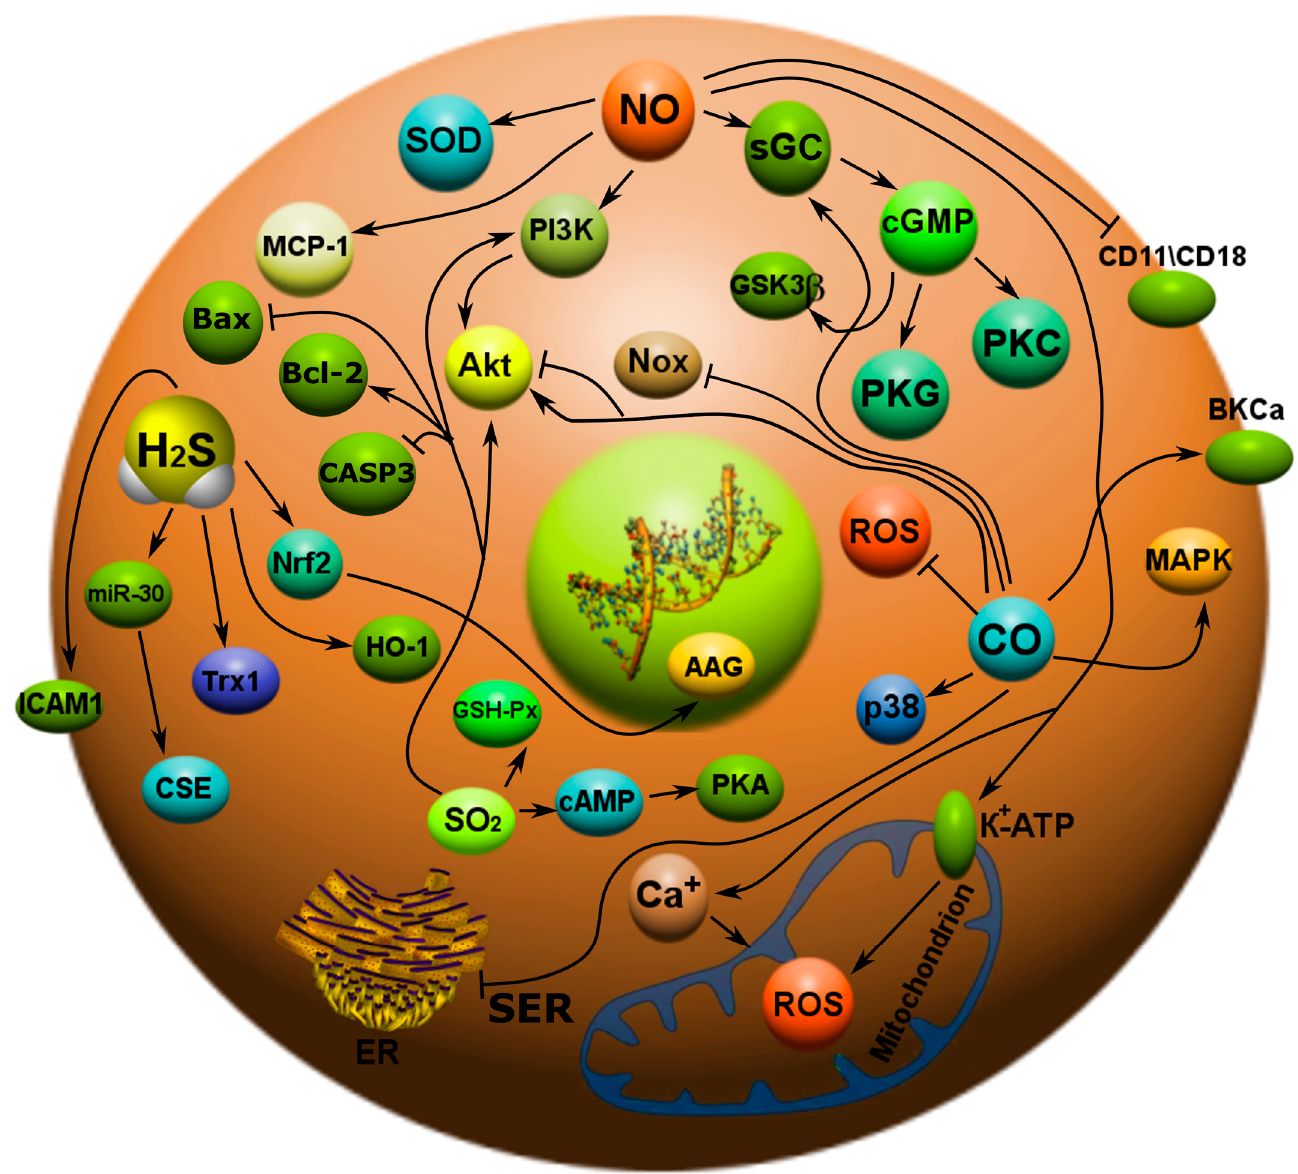
Figure 6. Possible gasotransmitter-dependent signaling mechanisms regulating apoptosis in cardiovascular diseases. NO, nitric oxide; CO, carbon monoxide; H 2 S, hydrogen sulfide; SO 2 , sulfur dioxide; SOD, superoxide dismutase; sGC, soluble guanylyl cyclase; cGMP, cyclic guanosine monophosphate; PKA, protein kinase G; PKC, protein kinase C; PKG, protein kinase G; PI3K, phosphoinositide 3-kinases; Akt, protein kinase B; Bax, bcl-2-like protein 4; Bcl-2, B-cell lymphoma 2; CASP3, cysteine-aspartic acid protease 3; MCP-1, monocyte chemoattractant protein 1; miR-30, microRNA-30; Trx1, thioredoxin 1; CSE, cystathionine γ -lyase; ICAM1, intercellular adhesion molecule 1; HO-1, heme oxygenase 1; GSH-Px, glutathione peroxidase; cAMP, cyclic adenosine monophosphate; MAPK, mitogen-activated protein kinase; p38, mitogen-activated protein kinase p38; BKCa, large conductance calcium-activated potassium channels; CD11\CD18, beta2 integrins, members of the integrin family; Nox, NADPH oxidase; K + -ATP, ATP-sensitive potassium channels; ROS, reactive oxygen species; Nfr2, nuclear factor erythroid 2-related factor 2; ER, endoplasmic reticulum; SER, stress endoplasmic reticulum; AAG, anti-apoptotic genes. Arrows with a sharp end—positive regulation; arrows with a blunt end—negative regulation.